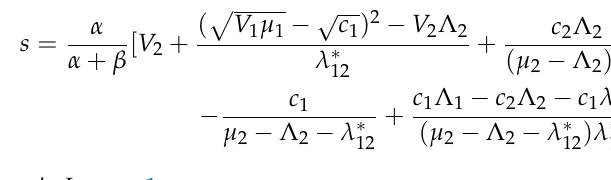
+ (cid:79) π ) / ( π 0 + π 0 ) 2 1 2 1